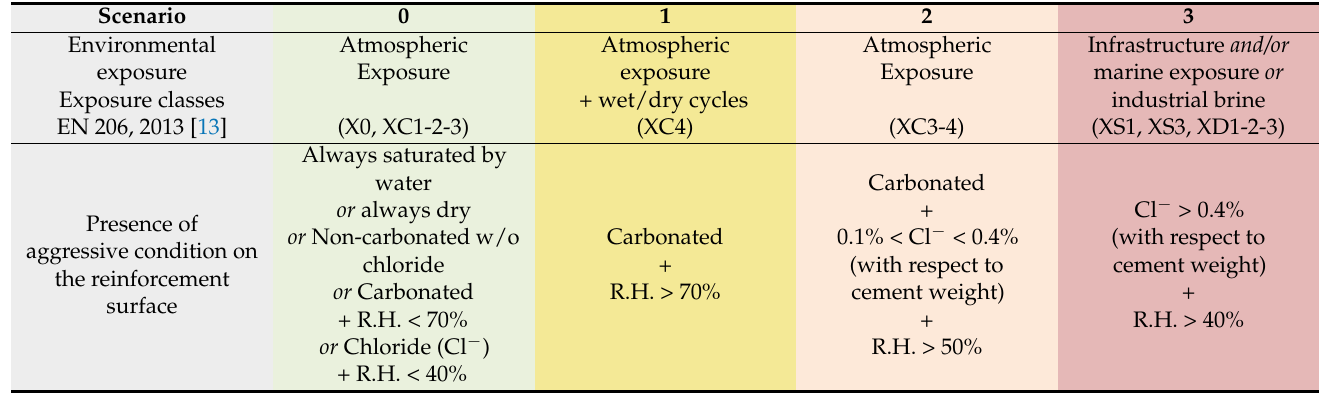
Table 4. Corrosion risk scenarios for reinforced concrete